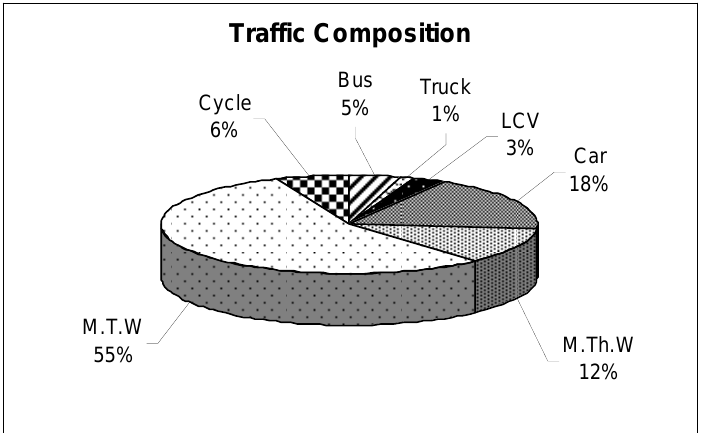
Figure 7. Representative traffic composition LCV- Light Commercial Vehicles, M.Th.W. –